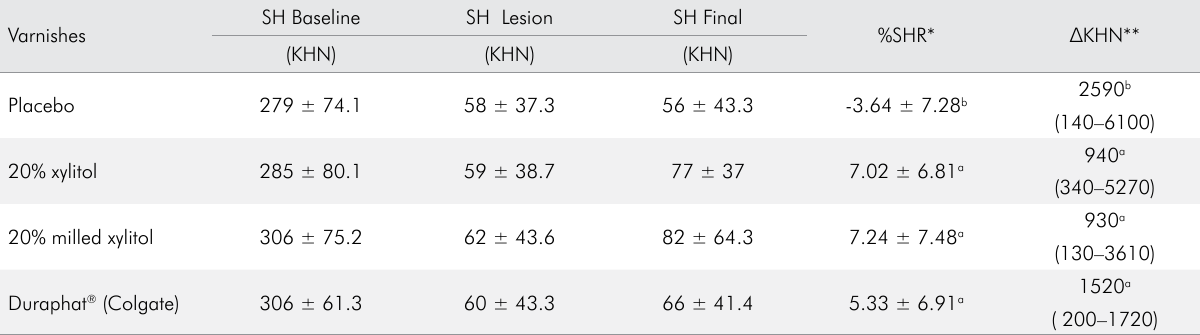
Table 3. Surface hardness measurements at baseline (SH baseline), after demineralization (surface hardness loss - %SHL), after treatment and in situ phase (SH final), percentage of surface hardness recovery (%SHR) and integrated mineral loss (ΔKHN) for the permanent teeth in situ (n = 15).